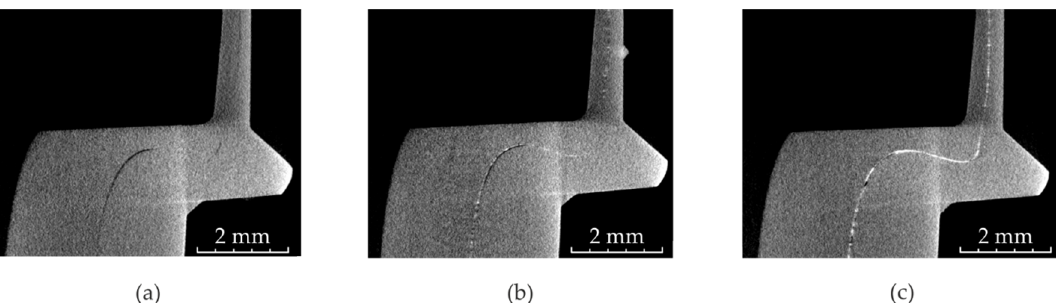
Figure 5. Half CT image of the specimens with copper spray applied to neither of the sheets ( a ), to one sheet ( b ) and to both sheets ( c ). Table 4. The results of the CT measurement of differently treated specimens.